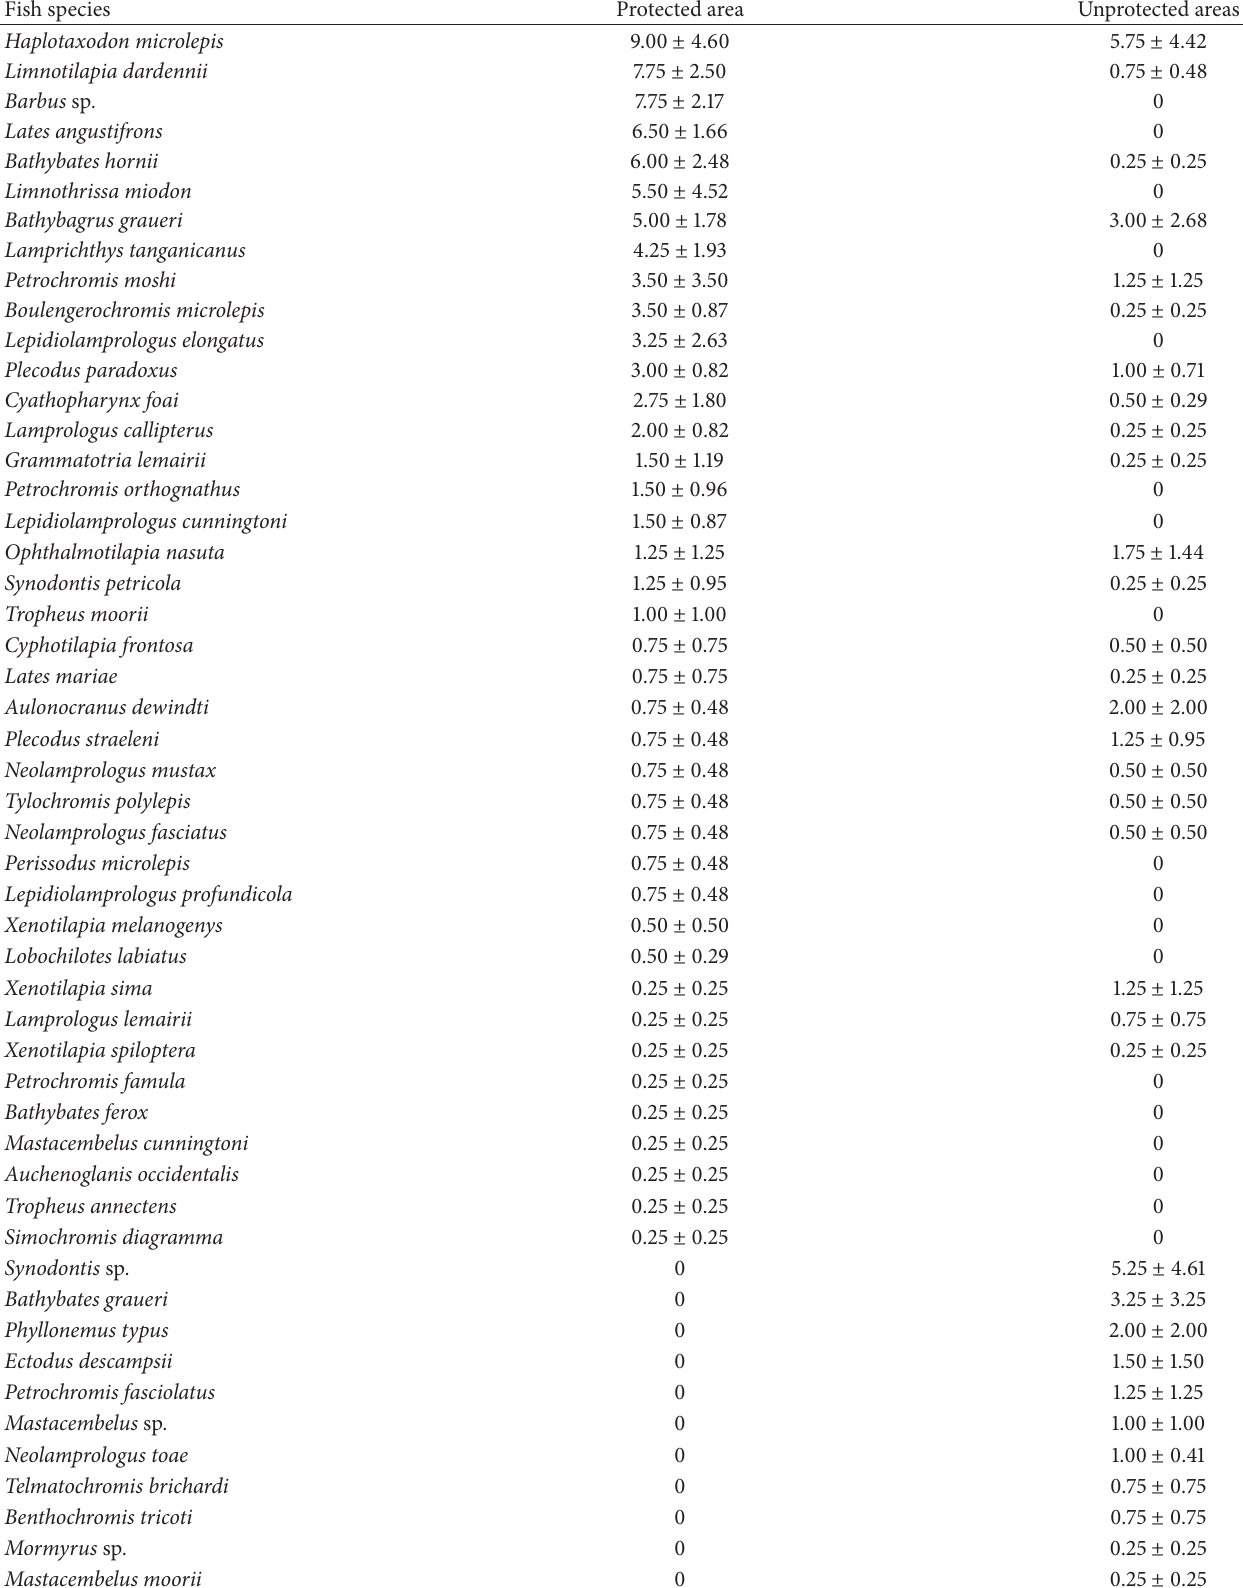
Table 2: Mean abundance number of individuals ( ± SE) of fish species sampled in sites within the protected area (MMNP) and unprotected areas (Buhingu and Sibwesa) in Lake Tanganyika, Tanzania, during 2008 gillnet